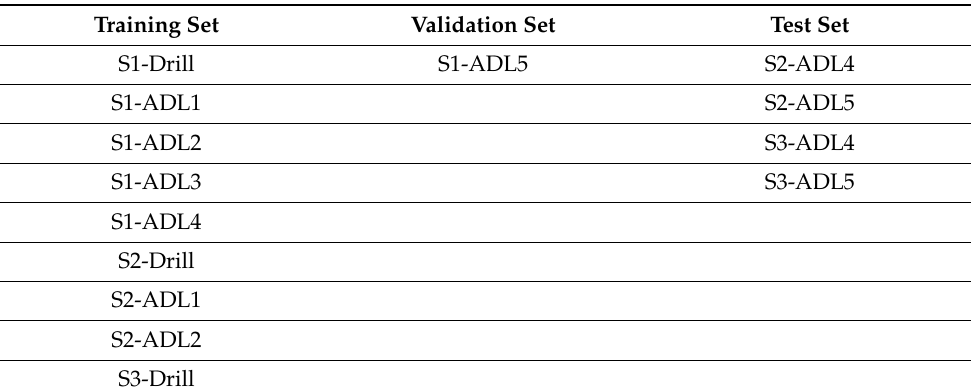
Table 3. The training, validation and test set in model development using OPPORTUNITY